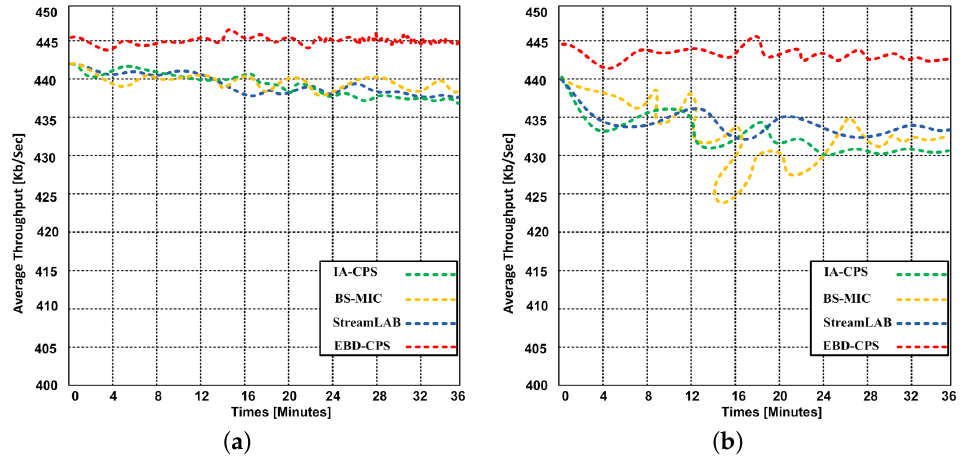
Figure 4. ( a ) Average throughput performance without malicious nodes of the proposed EDB-CPS and the contending models: IA-CPS, BS-MIC, and StreamLAB. ( b ) Average throughput performance with 5% malicious nodes for the EDB-CPS and contending models: IA-CPS, BS-MIC, and